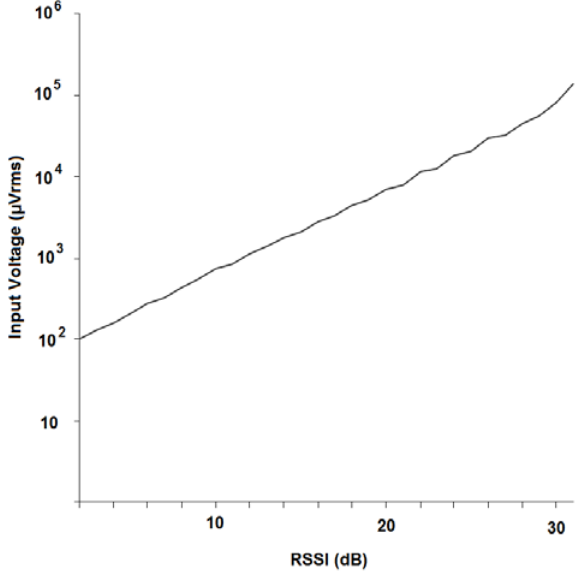
Figure 9. RSSI read for different input voltage